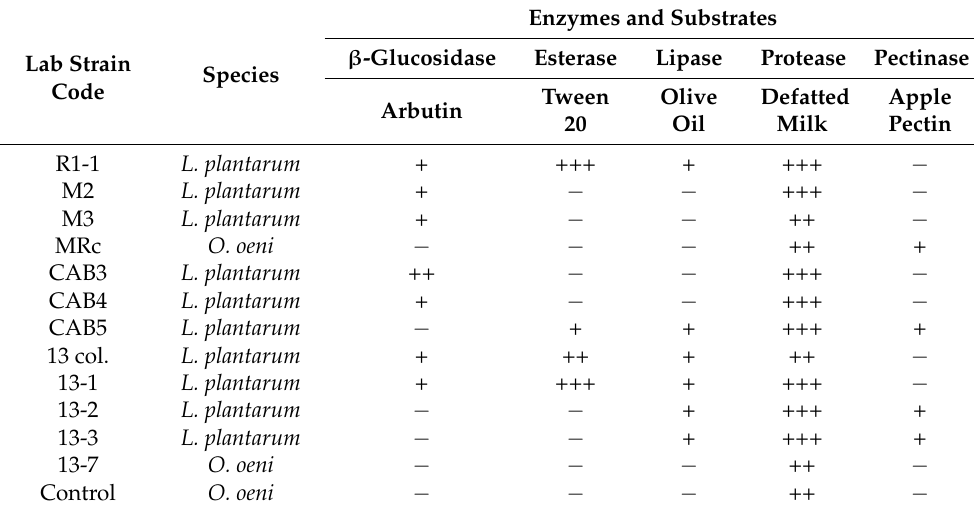
Table 1. Extracellular enzymatic activity of the tested lactic acid bacteria strains.